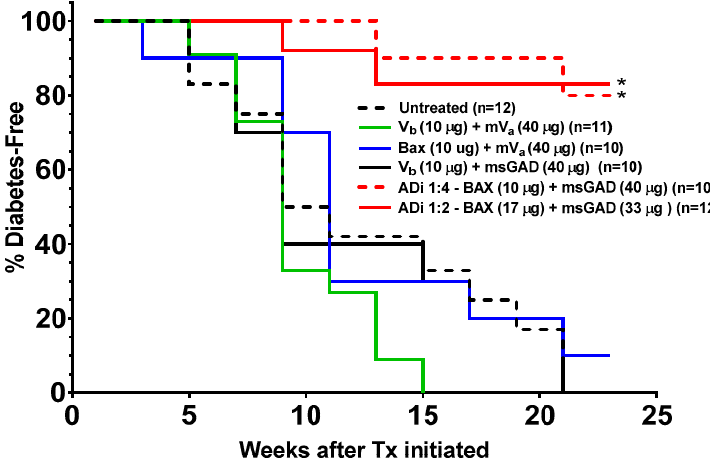
Figure 2. Two ADi-100 formulations containing di ff erent BAX and msGAD55 content suppressed the incidence of diabetes in NOD mice when treating mild hyperglycemia ( ≥ 140 mg / dL). Groups of 8-week-old female NOD mice were monitored weekly for fasting blood glucose (FBG) levels, and on the first day that FBG was ≥ 140 mg / dL (day 0; mild hyperglycemia), mice received an i.d. injection (50 µ L) once per week for 8 weeks of formulations containing 50 µ g total of di ff erent amounts of empty vectors (V b , BAX vector; mV a , methylated antigen vector) and those carrying BAX or msGAD55 [8]. Untreated mice did not receive any injection. The study was terminated once 100% of mice were diagnosed with diabetes in the untreated cohort (i.e., 2 FBG readings ≥ 300 mg / dL at least 7 days apart). The percentage of mice that remained free of diabetes in each cohort is presented. Note that raw FBG data per mouse used to calculate disease incidence for the first five cohorts (but not ADi-100 1:2) were obtained from data sets that appeared in our previous publication [8], but which were only presented as raw FBG data in a longitudinal format (mouse age); i.e., here, the data are represented in the form of “diabetes incidence” that includes the additional ADi-100 1:2 data that were not included in the previous publication. * p < 0.001 compared to untreated cohort.